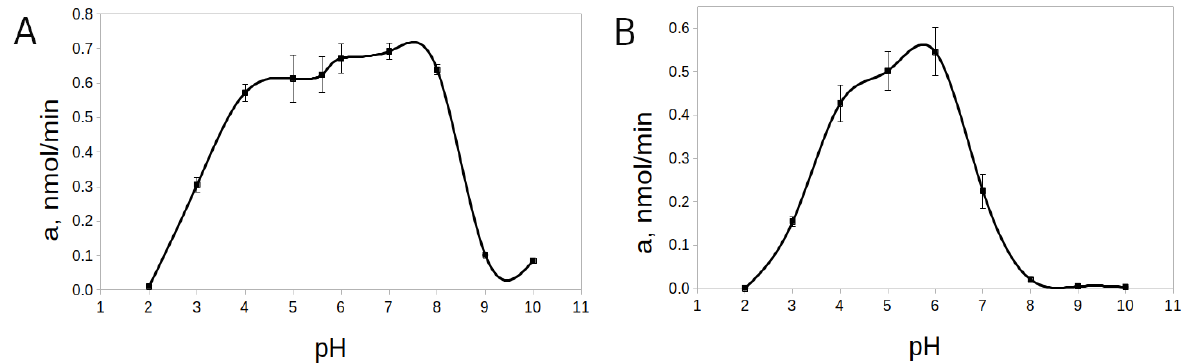
Figure 6. pH-stability of rTcCathL1 at 20 °C ( A ) and 37 °C ( B ). Activity was measured with the substrate Glp-Phe-Gln-pNA in 0.1 M UB, pH 5.6 in the presence of 6 mM cysteine and 1 mM EDTA.